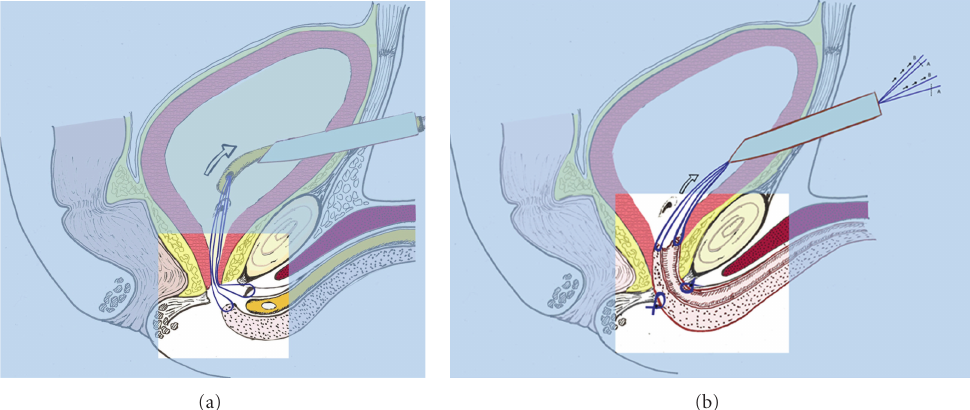
Figure 2: (a) Placing of 2 0-0 sutures at the proximal edge of the anterior urethra. They pass into the Nelaton supra-pubical catheter. (b) The proximal edge of the urethra is pulled through the pelvic floor and placed inside the Bladder. Polygalactinin 3–0 sutures are then placed in the proximal segment of the urethra between the para-urethral fascia and the vesico-urethral anastomosis. Afterwards the sutures exiting the Amplatz catheter are cut (A) and pulled out (B) of the